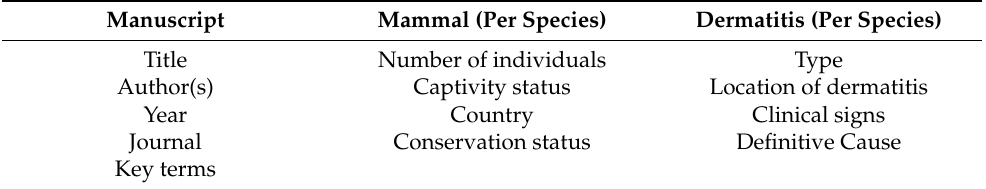
Table 1. Article Data Extraction: for each article, we collected information on the manuscript, the individuals per species, and the dermatitis exhibited by each